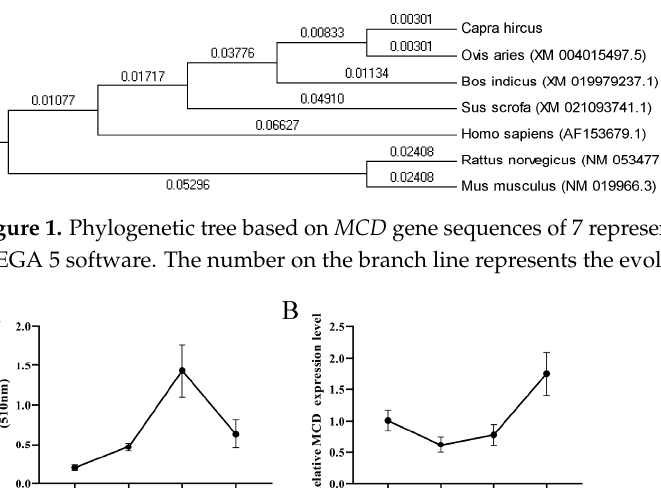
Figure 2. Relative expression level of MCD during intramuscular adipocyte differentiation. ( A ) Lipid